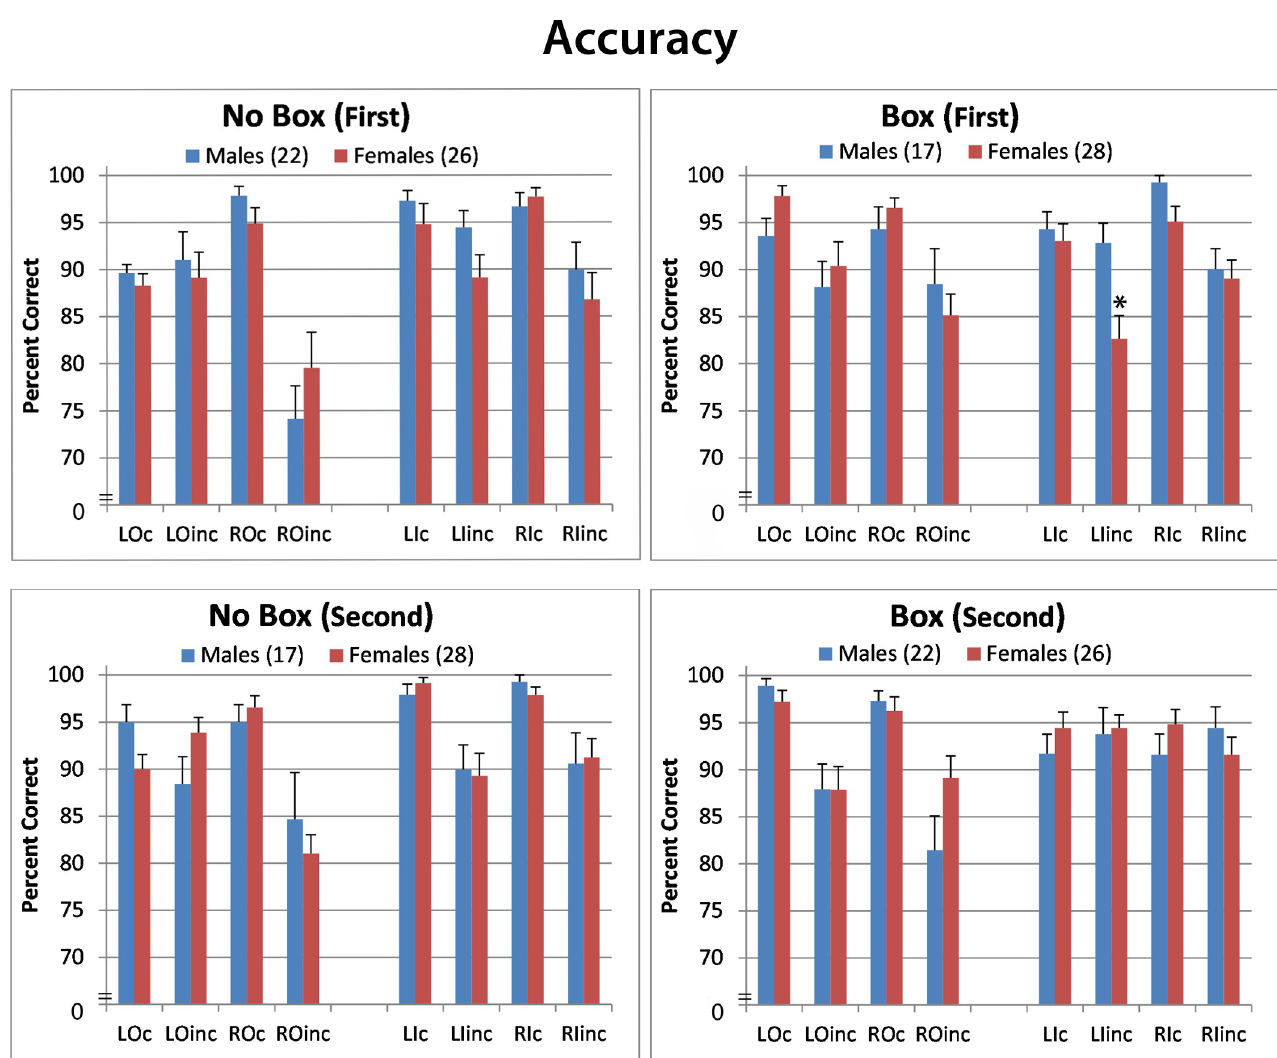
Fig 4. Accuracy (mean ± sem) for congruent and incongruent stimuli in males and females across Box/No Box conditions, order of presentation, Left/ Right side of presentation, and position. � p < 0.05 from opposite sex. L = left; R = right; O = outer; I = inner; c = congruent; inc =